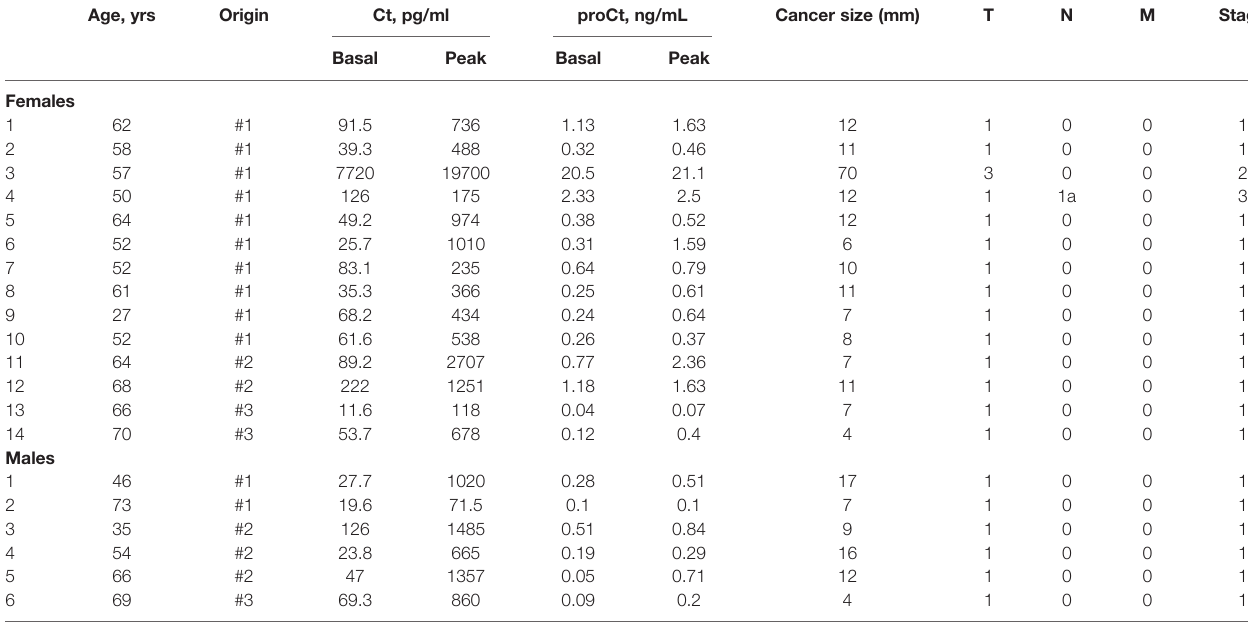
TABLE 3 | Clinical features of the patients submitted to calcium-stimulation test with a fi nal histological diagnosis of MTC. Age, yrs